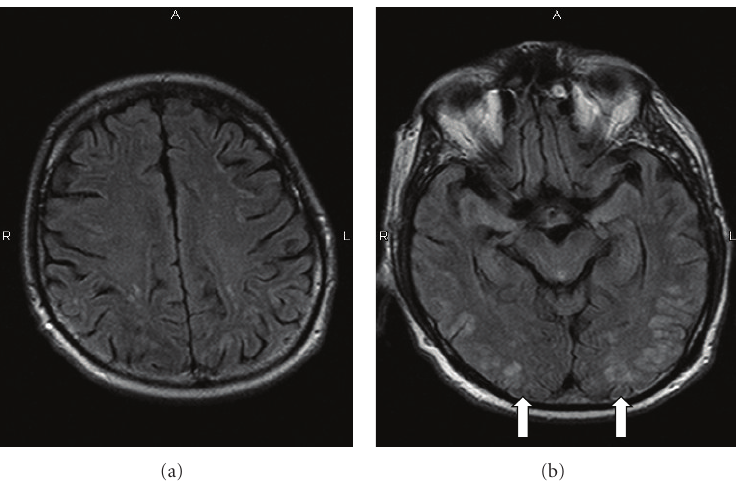
Figure 1: FLAIR AXIAL MRI images (TR 4140, TE 117) of the initial admission demonstrating multiple small bilateral cortical hyperinten- sities especially involving the occipital lobes (arrows). There was no evidence of mass e ff ect or contrast enhancement on postcontrast images (not